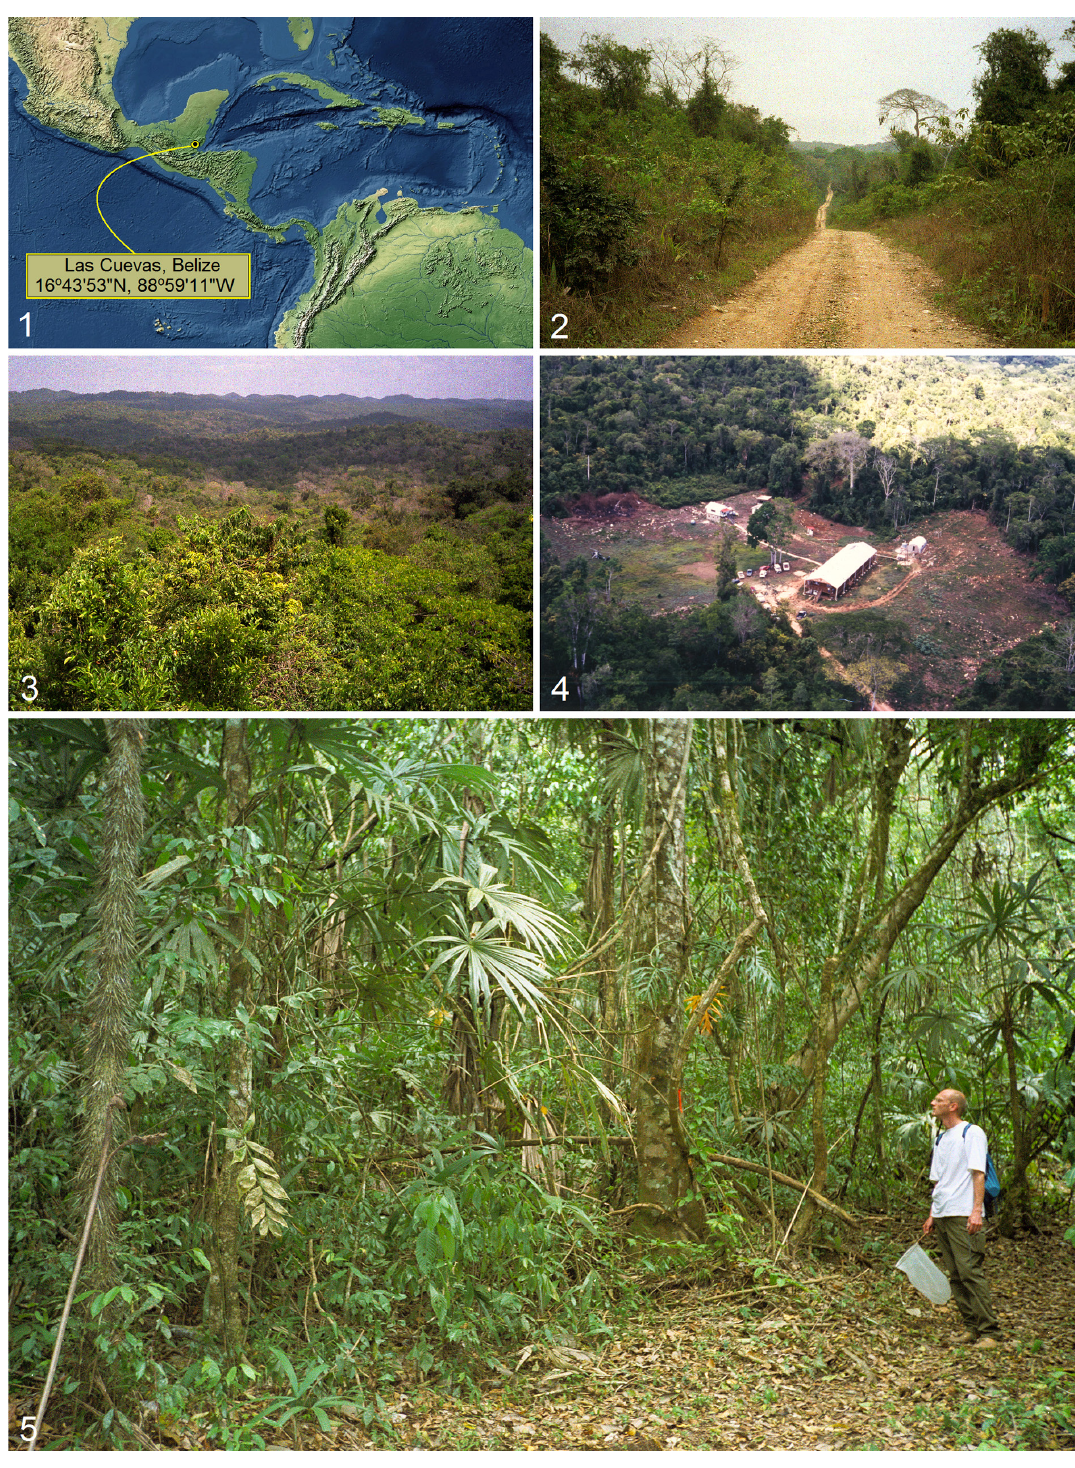
Figs 1–5. Map and locality. 1 . Las Cuevas, Belize, Central America, 16°43′53″ N, 88°59′11″ W (Map base courtesy of T. Patterson, USA). 2–3 . Road to Las Cuevas Research Station, located in the heart of the Chiquibul Forest in the Maya Mountains of Belize. 4 . The site of Las Cuevas Research Station (formerly Las Cuevas Biological Station), shortly after its establishment by the Forest Department of Belize and the Natural History Museum, London in 1994 (courtesy of NHMUK). 5 . Habitat, moist tropical forest (at right, collector Simon R. Hill,